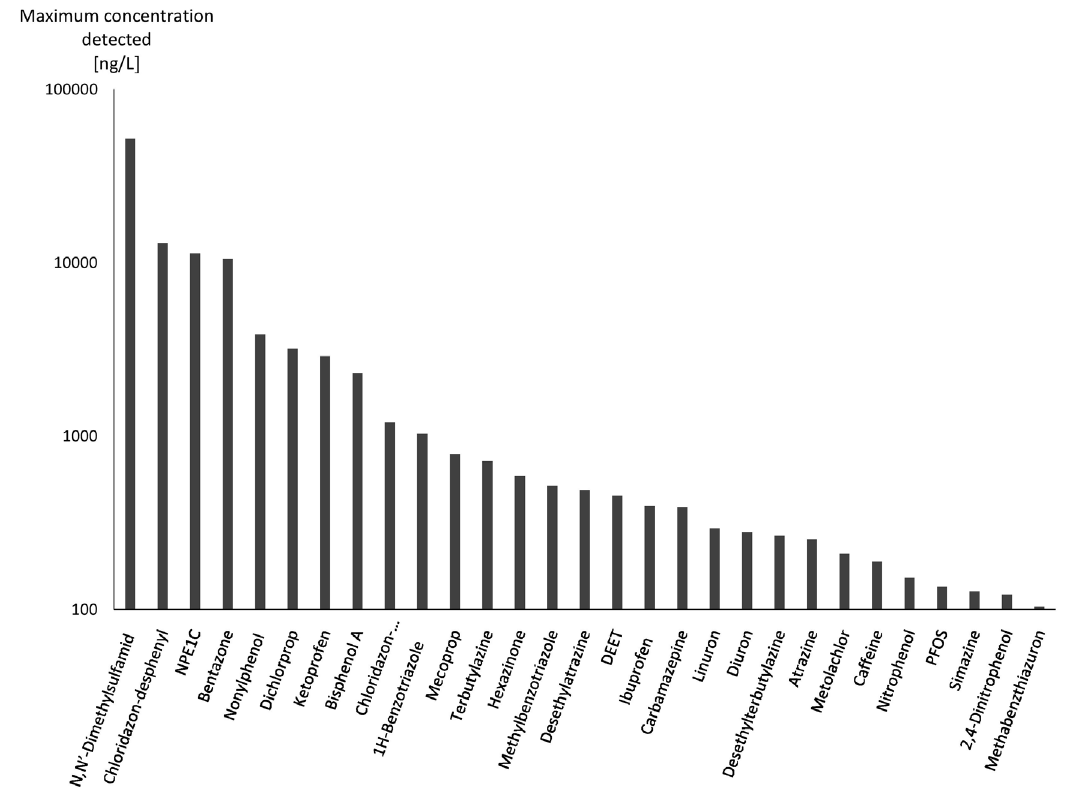
Figure 2: Maximum concentrations for compounds present in 20% or more of samples detected by Loos et al.